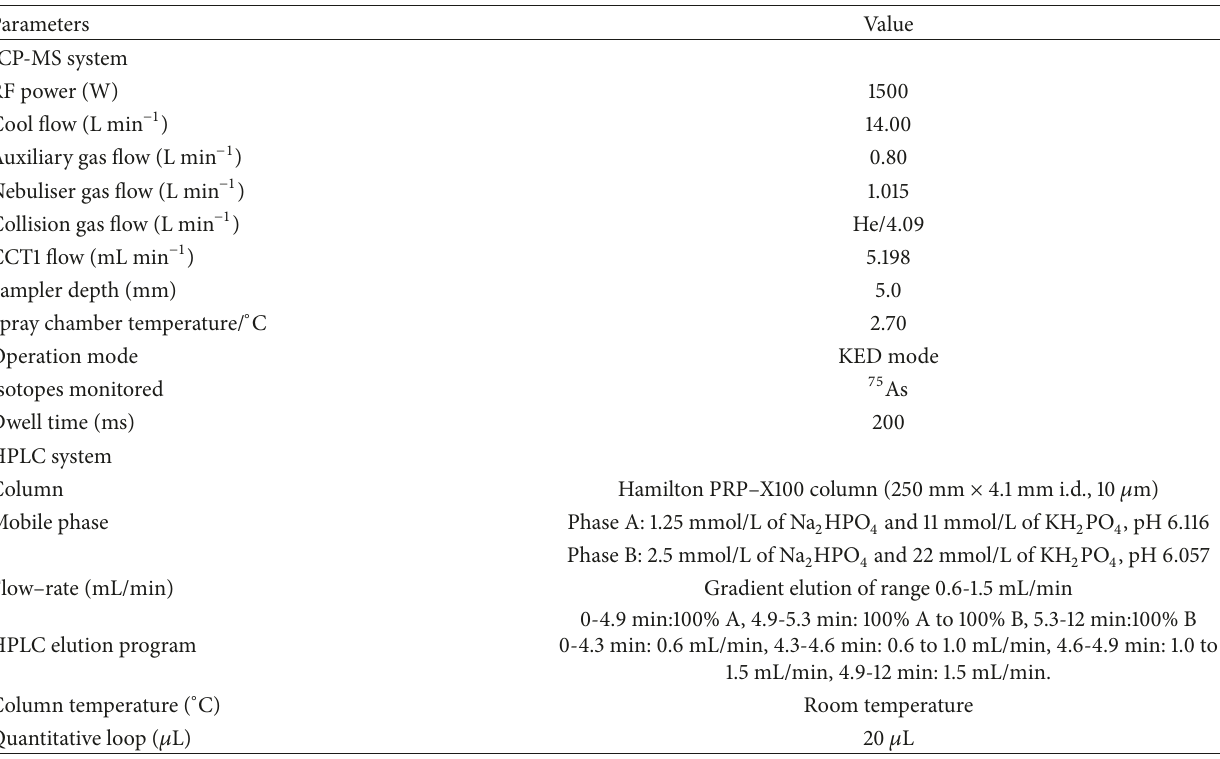
Table 1: Working conditions of the HPLC and ICP–MS